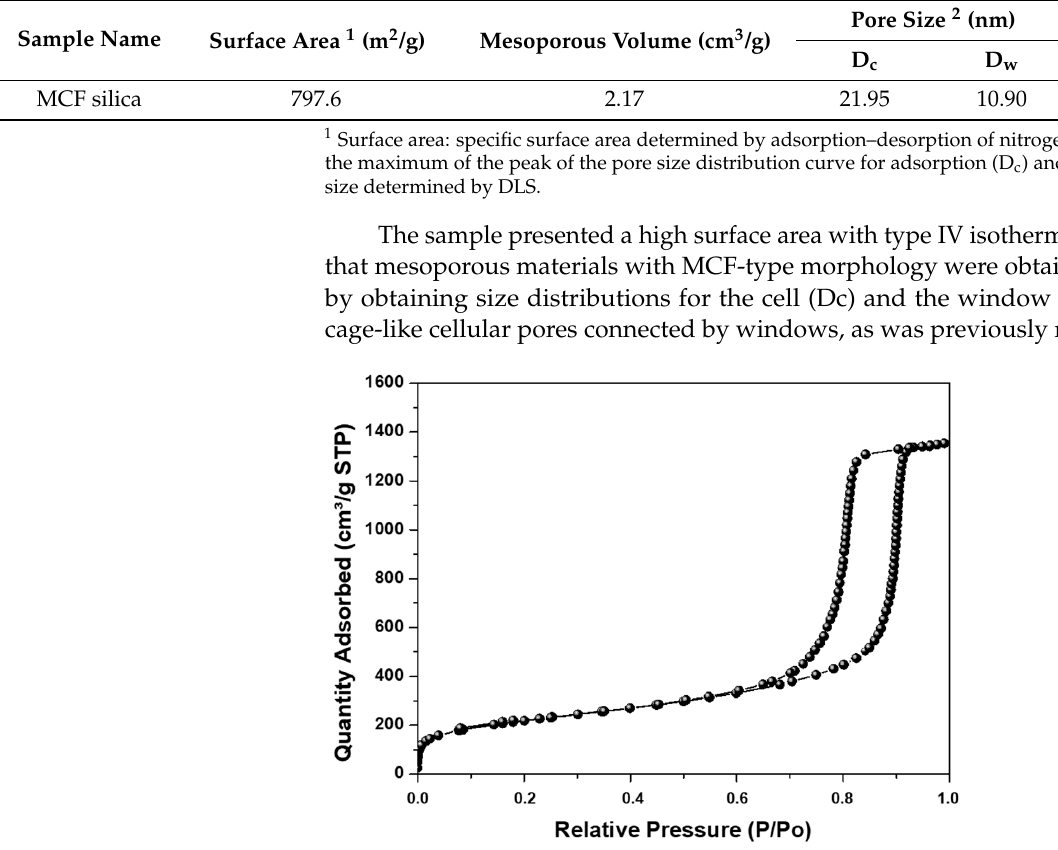
Figure 5. Nitrogen adsorption–desorption isotherm of MCF-type